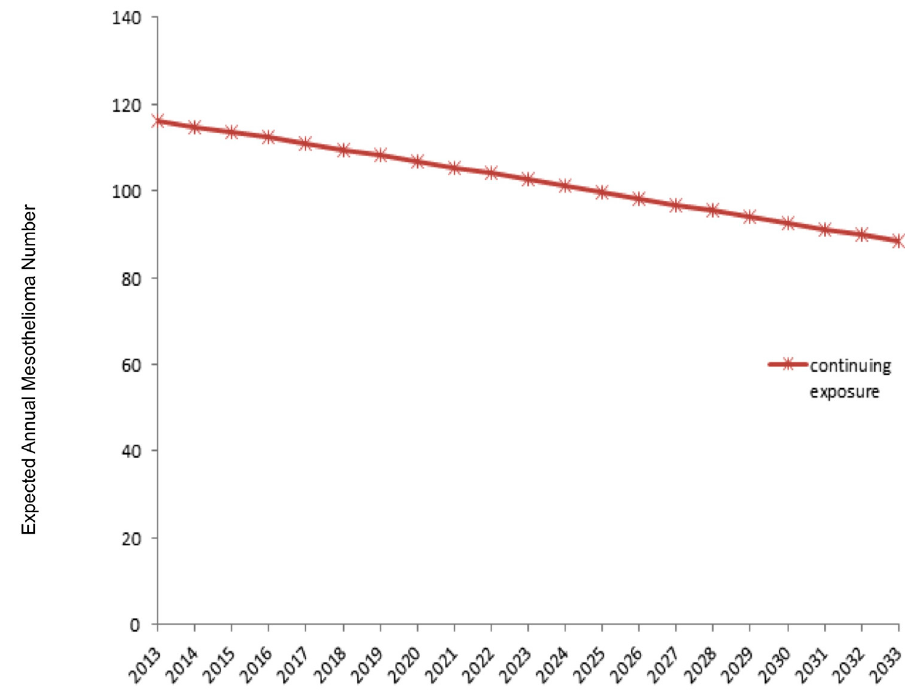
Figure 4. New mesothelioma cases expected among subjects who will continue to be exposed to asbestos after 2013.